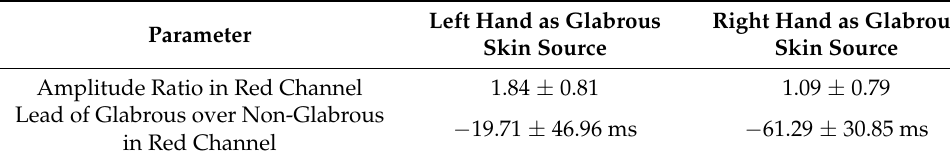
Table 2. Statistically significant results for paired testing ( p <